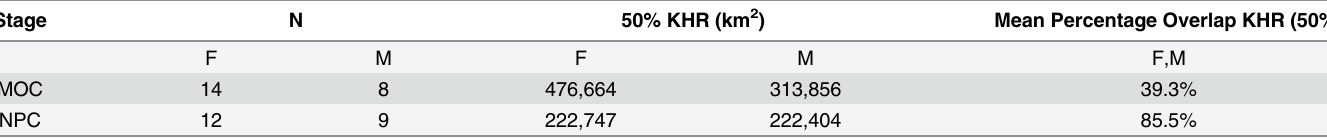
Table 3. Seasonal kernel home range areas (KHR; km 2 ) and percentage overlap of core foraging areas (50% kernal distribution) of female and male murres during MOC and NPC. Stage